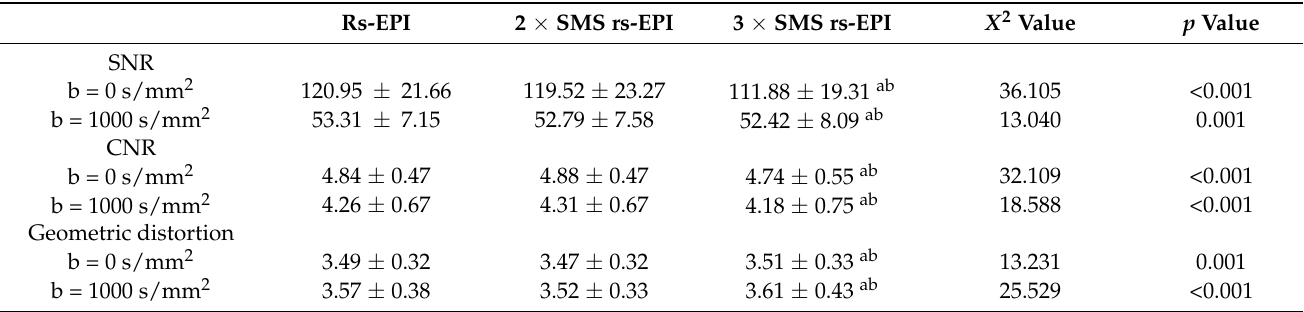
Table 4. Comparison of quantitative evaluation indexes of three EPI sequences.